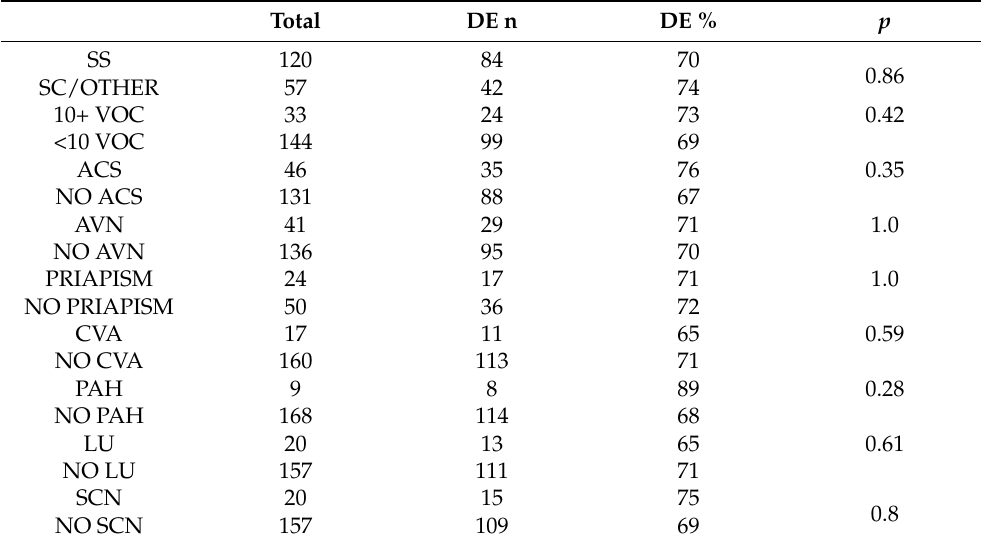
Table 1. Association between dental extraction and sickle cell clinical characteristics. Total DE n DE